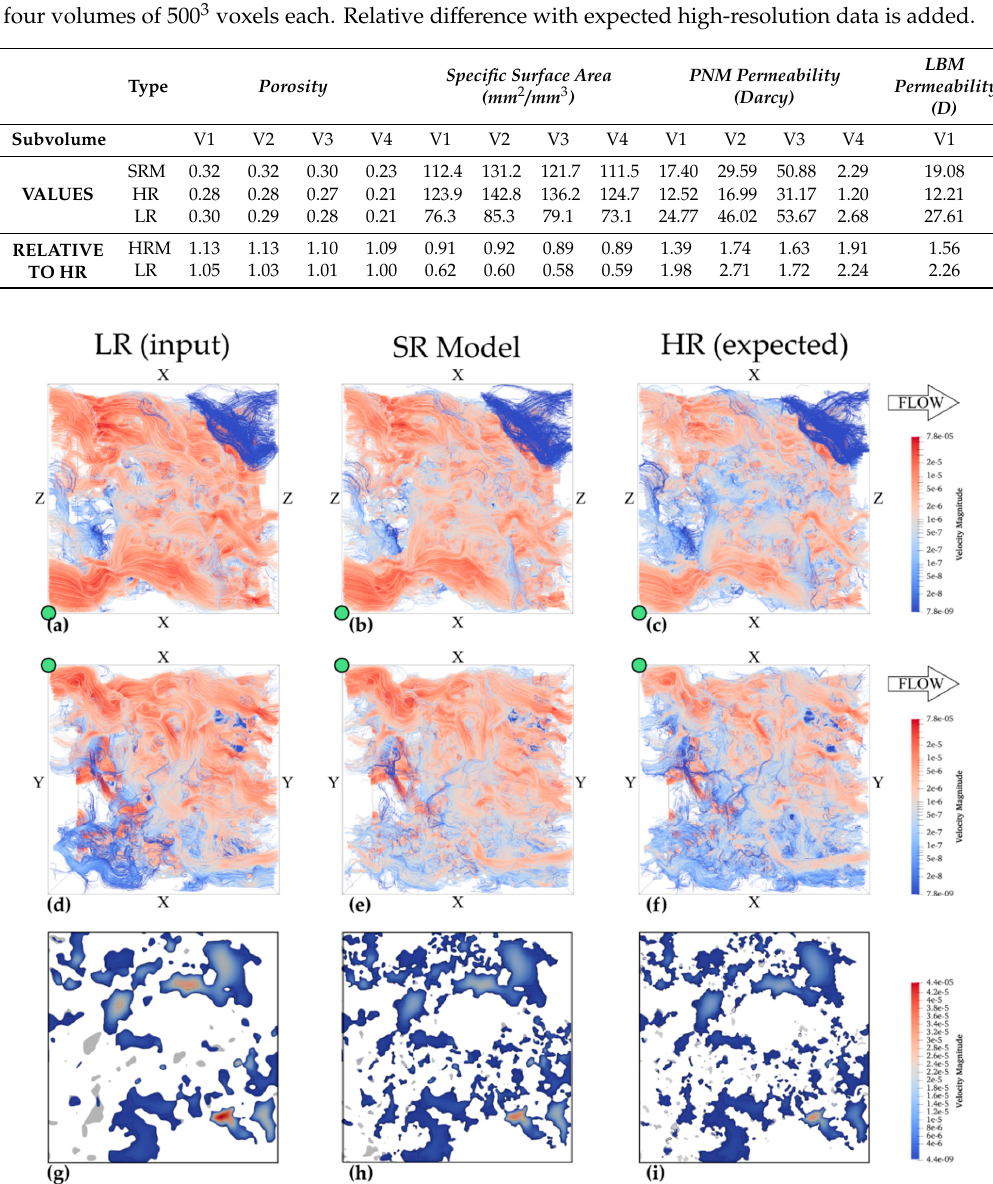
Figure 8. Visualization of lattice Boltzmann simulations in 3D along a side view (X-Z) and a bottom view (X–Y) in which the green dots indicate the same point in each volume that was added for orientation. Fluids flow from left to right and red indicates higher fluid flow velocities, while blue indicates slower fluid flow. In the top row ( a – c ), the HR sample ( c ) has two higher fluid velocity zones with a lower fluid velocity zone in the middle. This distinction is less obvious in LR sample ( a ), while the slightly bluer colour in the middle of SRM ( b ) suggests a certain improvement of the model. The middle row ( d – f ) show an unconnected zone in the lower left corner of the LR sample ( d ), which is again connected in the SRM image ( e ), as it should be, as shown in ( f ). The bottom row ( g – i ) shows a 2D slice perpendicular to this flow and is taken in the middle of the sample. In this slice, the grey colours indicate unconnected porosity. These slices show that the SRM ( h ) have more pores and are better connected than the LR volume ( g ). However, connectivity and fluid flow velocities are still exaggerated compared to HR ( i ). This is also seen from the 3D volumes where SRM volumes ( b , e ) have a redder colour than HR ( c , f ), although it is slightly more blue than LR volumes ( a , d